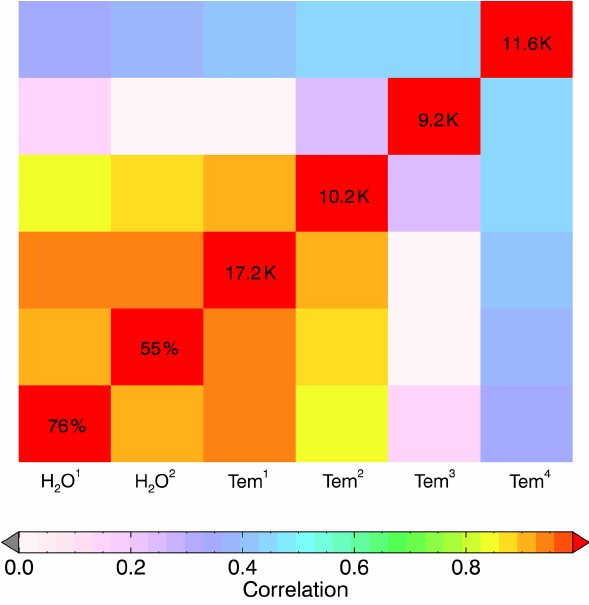
Figure 4. The correlation matrix is shown for the sample covariance of the H 2 O and atmospheric temperature layers calculated from the 80-atmosphere RTTOV ensemble. The standard deviations are an- notated along the diagonal elements for